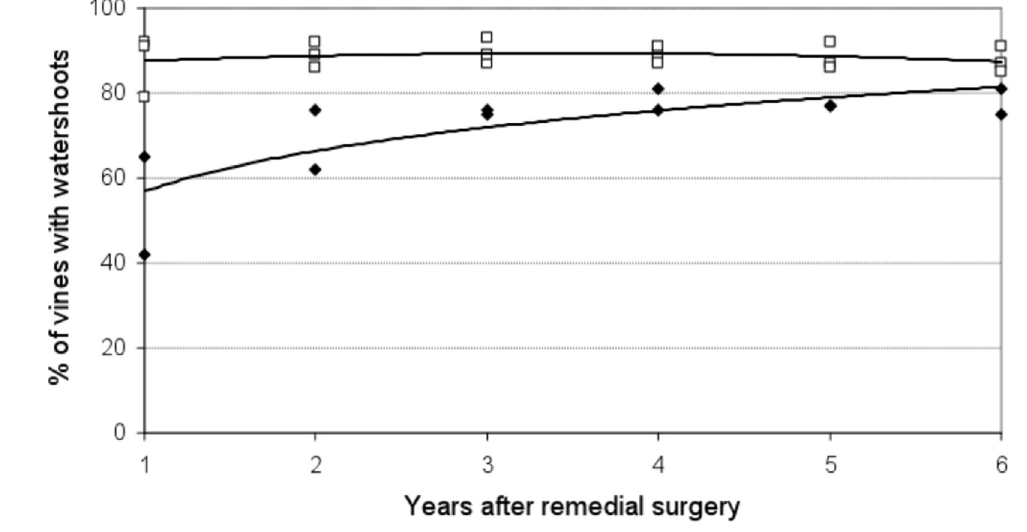
Figure 1. Relationship between incidence of watershoot production and years after remedial surgery for low-cut ( ¿ Trials 2 and 5, R 2 =0.62) and high-cut ( ¨ , Trials 3, 4 and 6, R 2 = 0.05) ‘Shiraz’ vines in the Eden Valley and Coona- warra regions of South Australia.